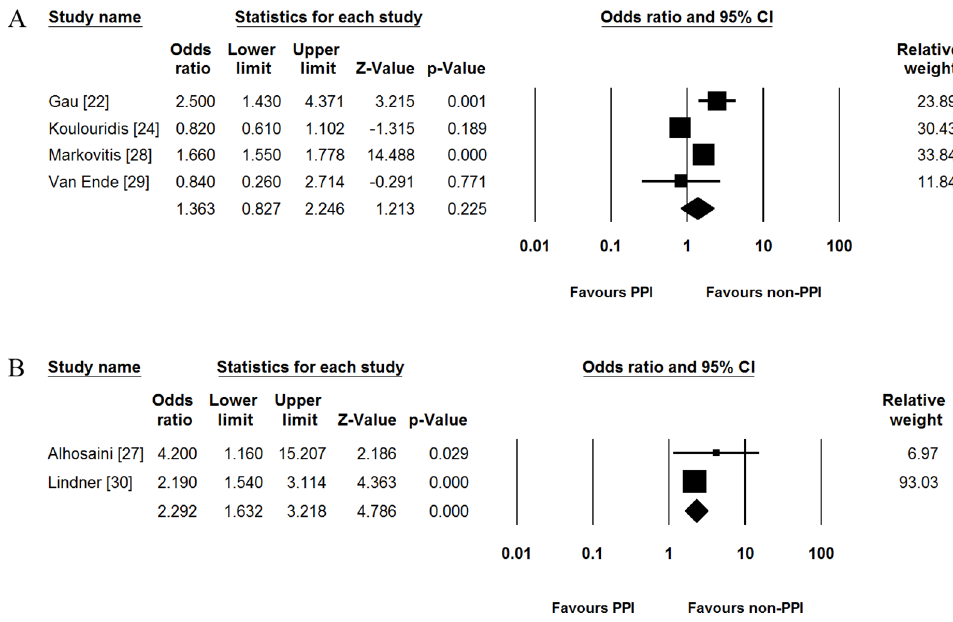
Figure 4. Subgroup analysis according to the cut-off value of serum magnesium levels. (A) Subgroup analysis for studies based on the 1.7 mg/dL of cut-off value. (B) Subgroup analysis for studies based on the 1.8 mg/dL of cut-off value. PPI, proton pump inhibitor; CI, confidence interval.